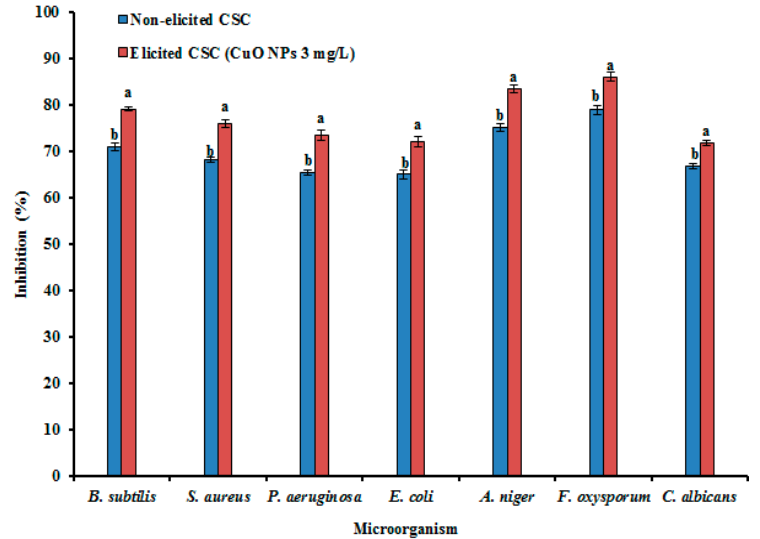
Figure 6. Effect of CuO NPs on antimicrobial activity in CSC of G. sylvestre using the disc diffusion method. Different letters indicate a significant difference at p ≤ 0.05.